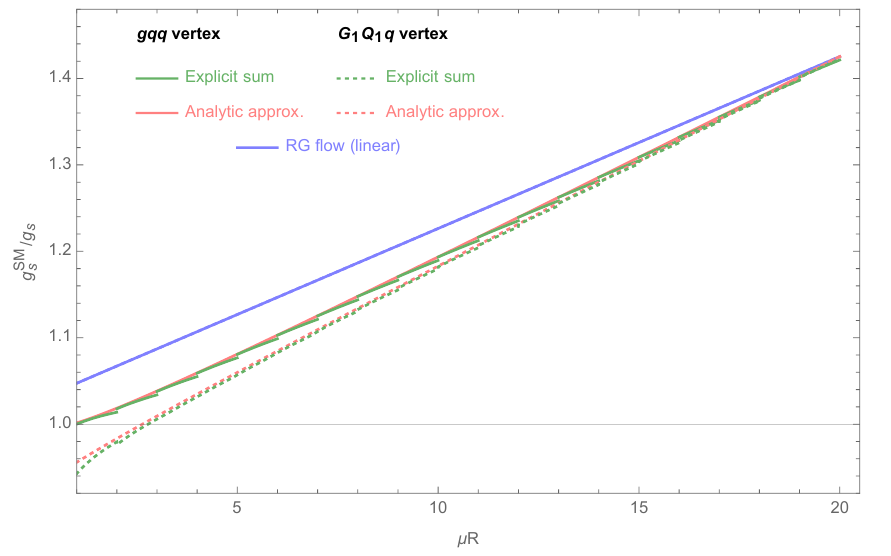
Figure 5 . Running of the SM vertex function q (cid:0) q (cid:0) g (solid line) and the KK vertex q (cid:0) Q 1 (cid:0) G 1 (dashed line). We compare the full summation up to the cuto(cid:11) with the asymptotic expansion as well as the results obtained from the FRGE running. The integration constants have been (cid:12)xed such that the couplings coincide at (cid:3) R =